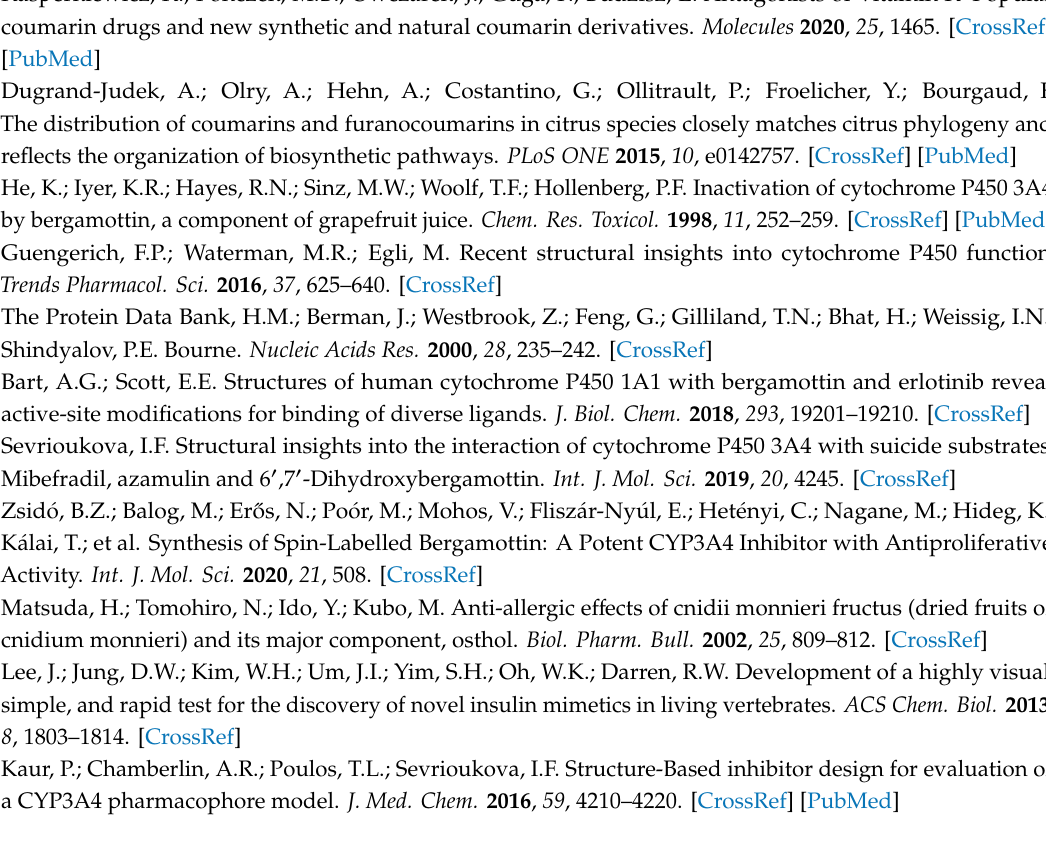
Supplementary Materials: The following are available online. Figure S1–S4: X-ray di ff raction molecular structure results of Bergamottin, Fraxidin and Osthole, Figure S5–S10: Results of computational calculations, Tables S1–S3: Bergamottin, Osthole, Fraxidin atomic coordinates and equivalent isotropic displacement parameters. Supplementary crystallographic data for this paper are deposited at the Cambridge Crystallographic Data